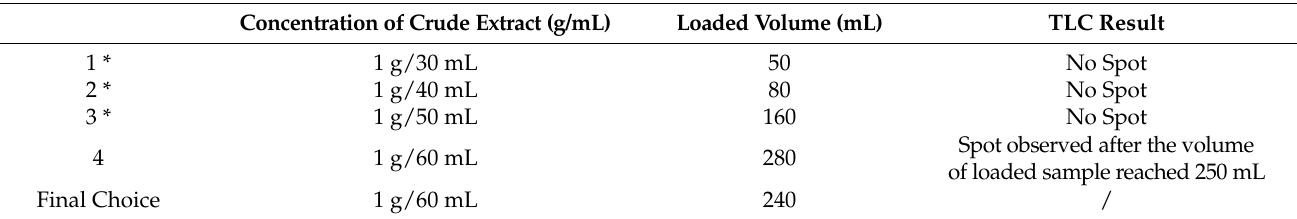
Table 1. The screening of the best concentration and the amount of loaded sample on macroporous resin (100 g) chromatography. Concentration of Crude Extract (g/mL) Loaded Volume